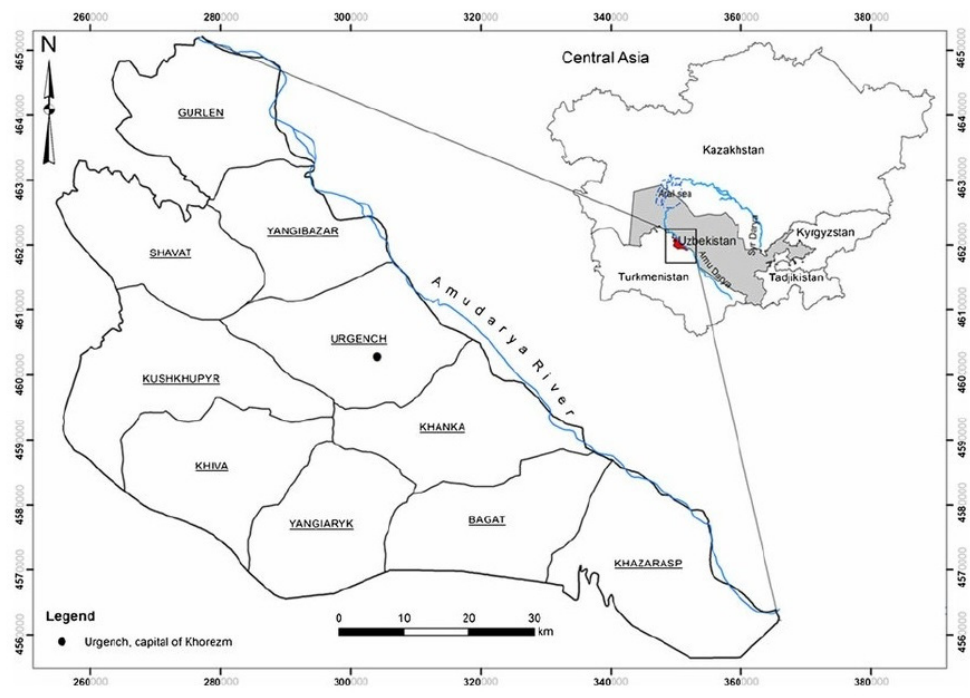
Figure 1. Map of the Khorezm region, Uzbekistan.